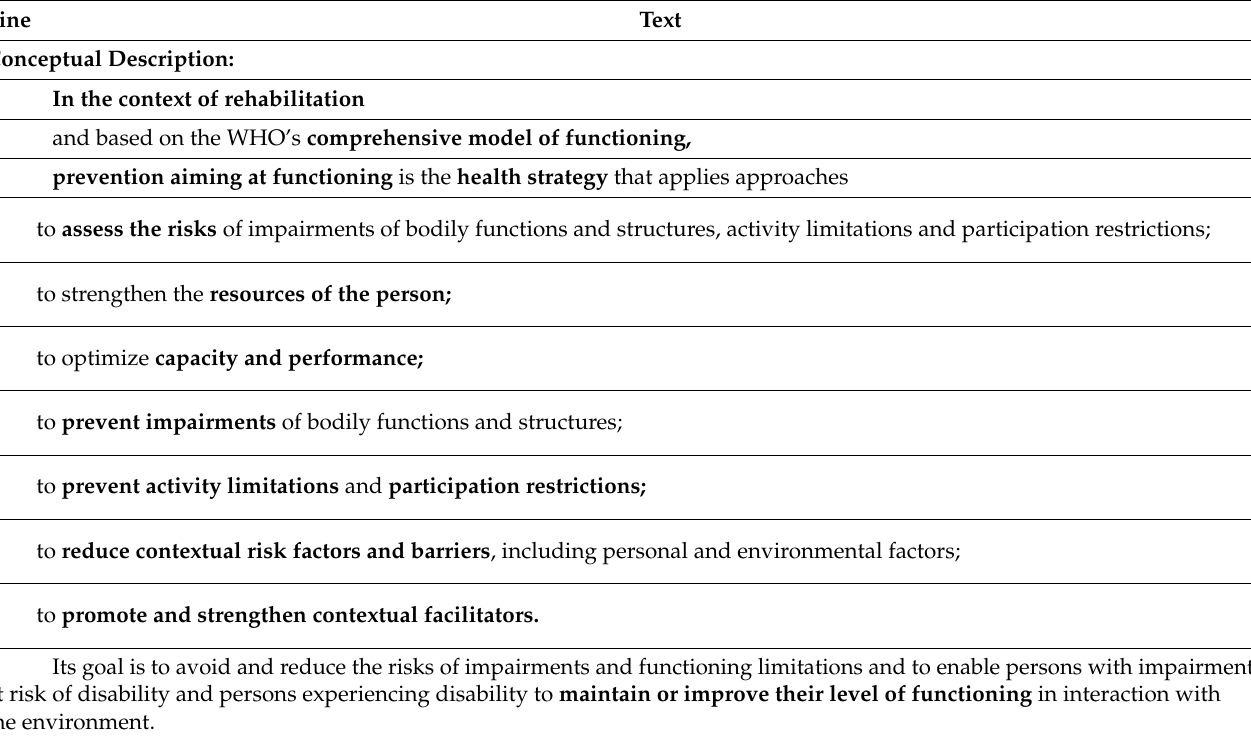
Table 1. Proposal for a conceptual description of prevention aiming at